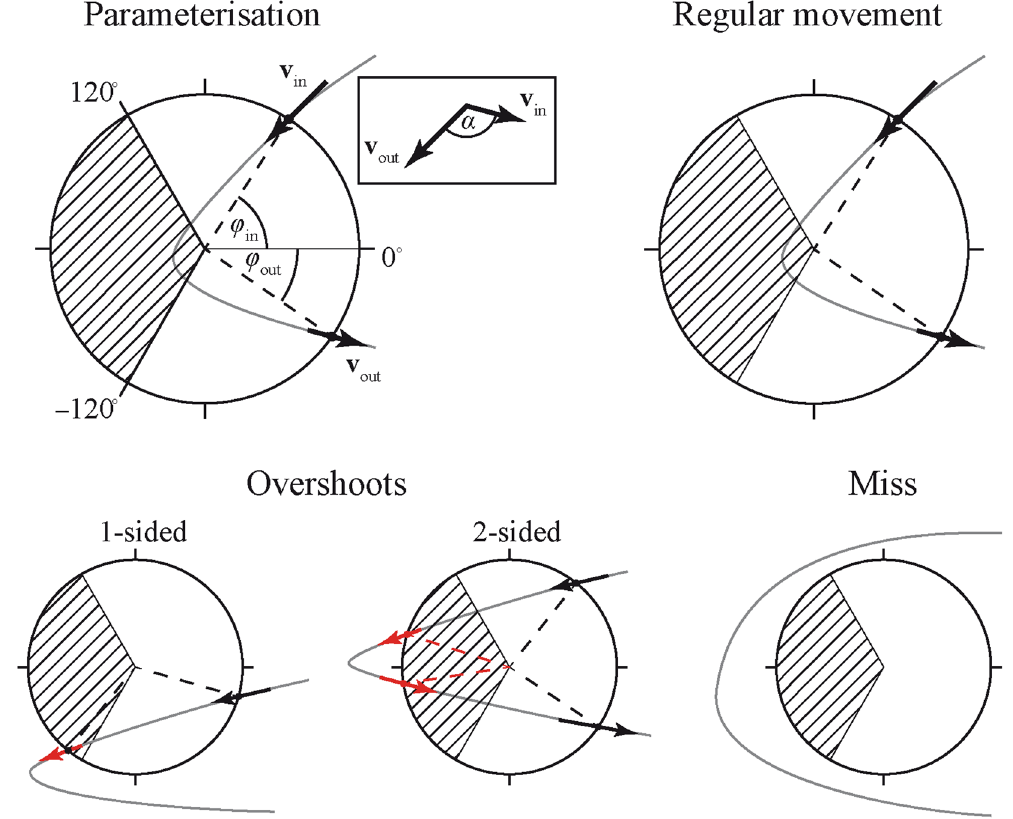
Figure 8. Geometrical movement parcellation and identification of the targeting phase, illustrated for a right to left movement. V in and V out represent the vectors and the entry and exit point, respectively, with α being the angle between the vectors. The angle between of the radius at 0° and the radius to the intersection of the movement with the target ( ϕ in and ϕ out) should not exceed 120°. The shaded area is the area with ϕ in and/or ϕ out being bigger than 120 degrees. A black arrow signifies a correct entry or exit, whereas a red arrow represents an entry or exit that did not meet the requirements. Errors were identified as 1-sided overshoots if a least one entry or exit was exceeding the requirements. 2-sided overshoots had at least 2 entries and 2 exits. Misses did not have any intersections with the